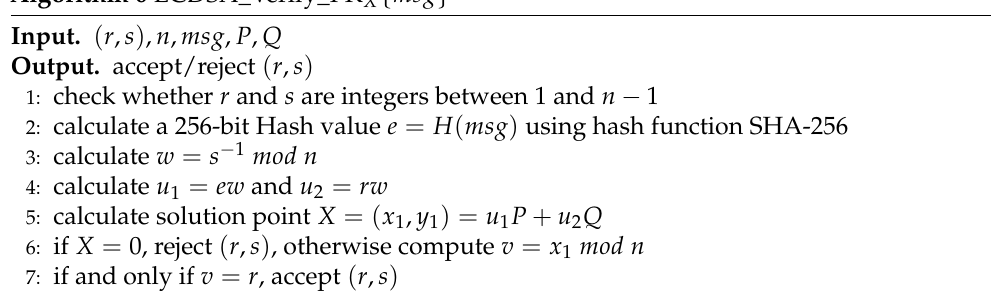
Algorithm 6 ECDSA_Verify_PK X { msg